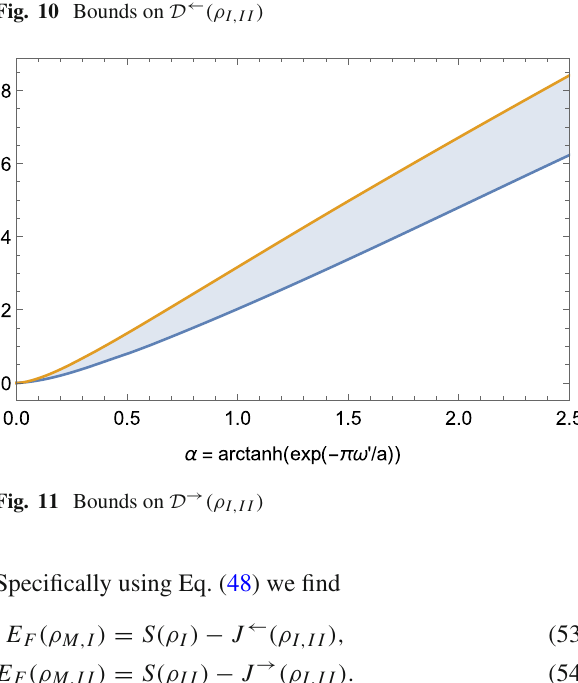
Fig. 12 Upper bound on E F (ρ M , I )